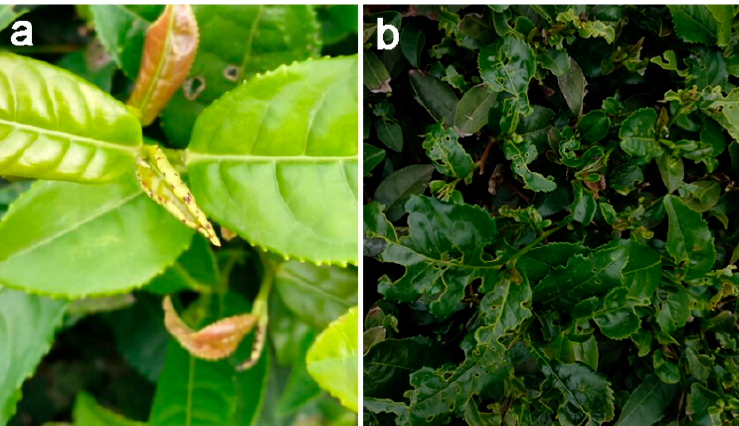
Figure 1. Young tea shoots ( a ) and tea leaves ( b ) damaged from probing by mirid bugs.